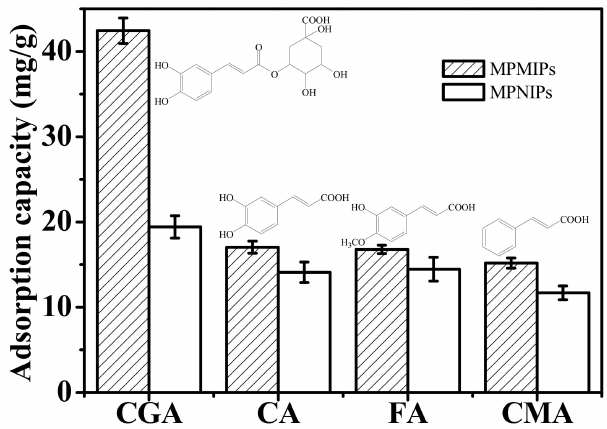
Figure 4. Adsorption capacities of 1.2 mg/mL of CGA, CA, FA, and CMA on MPMIPs/MPNIPs for 35 min ( n =